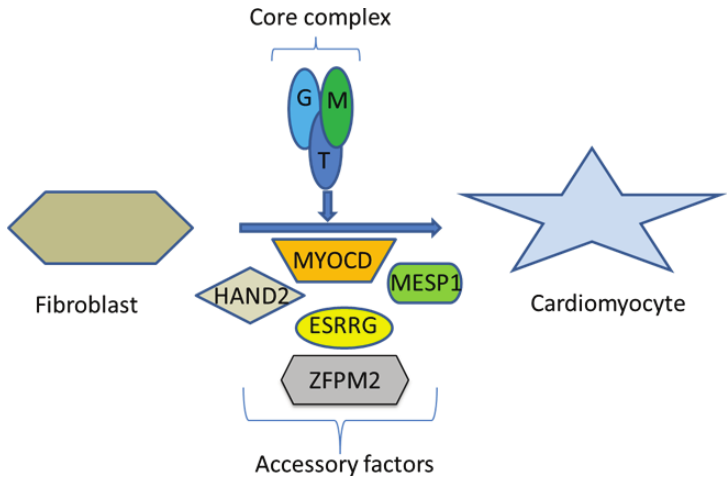
Figure 1. A schematic diagram of the cardiogenic program. Core complex consisting of cardiac transcription factors TBX5(T), GATA4 (G) and MEF2C (M) is sufficient to reprogram fibroblasts to cardiomyocytes. Other accessory factors (HAND2, ZFPM2, MYCOD, MESP1 and ESRRG) enhance the transformation